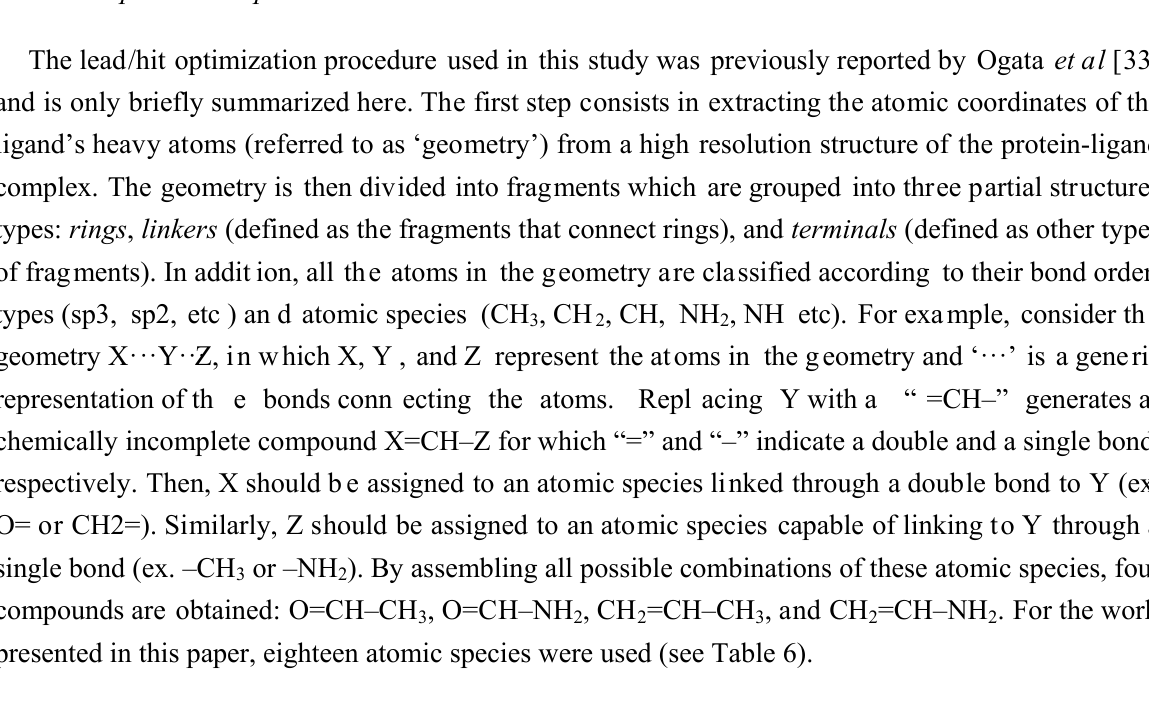
Table 6. Atomic Chemotypes used in this